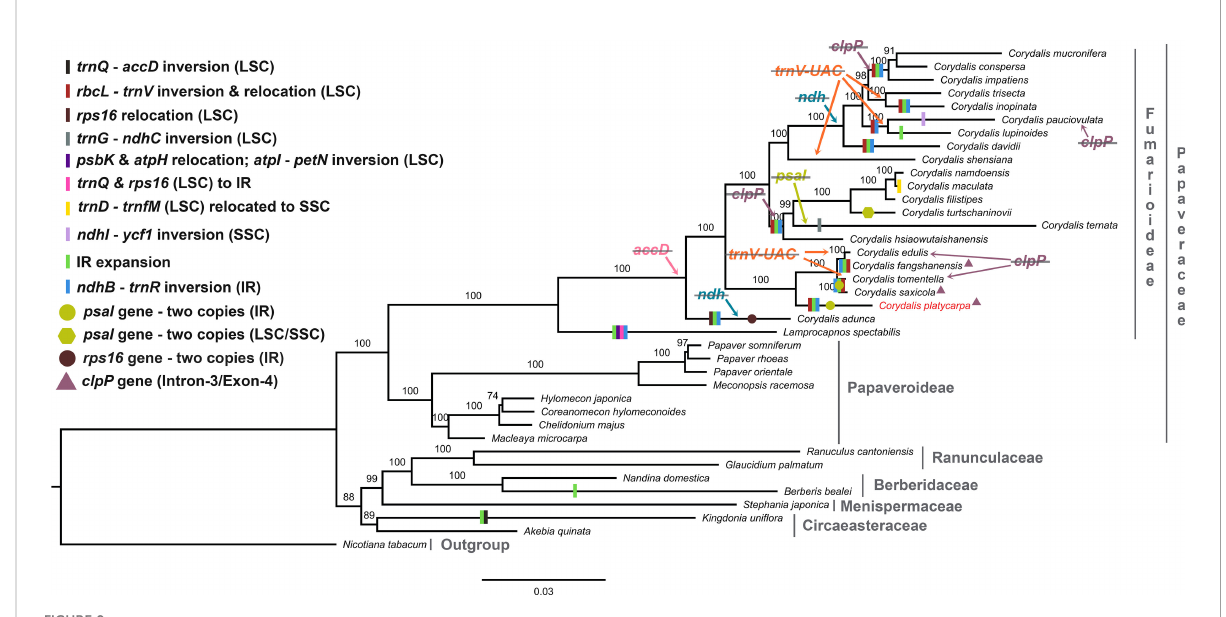
FIGURE 9 Maximum likelihood (ML) tree for 38 taxa based on 59 common plastid protein-coding genes. Values above the branches represent the maximum likelihood bootstrap